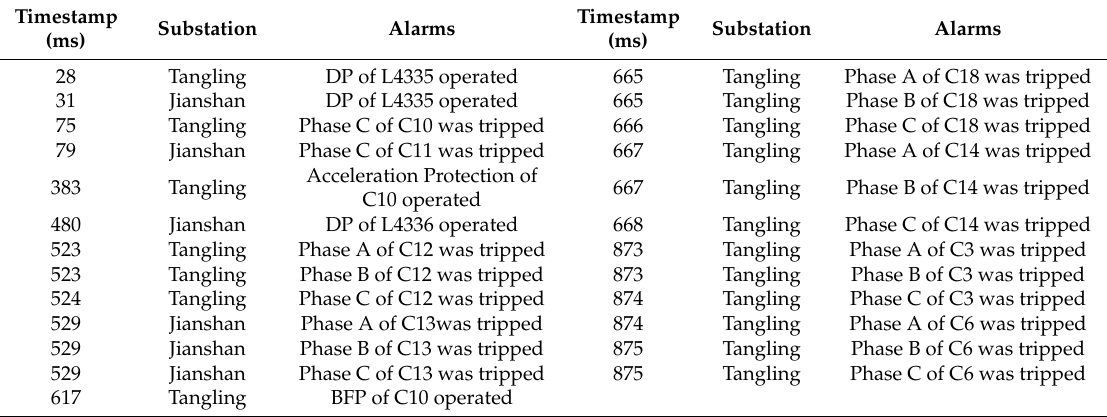
Table 1. Received Alarm.